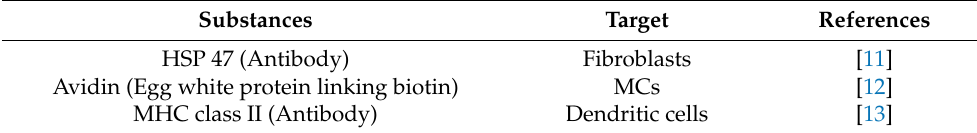
Table 1. Reagents used to stain inflammatory